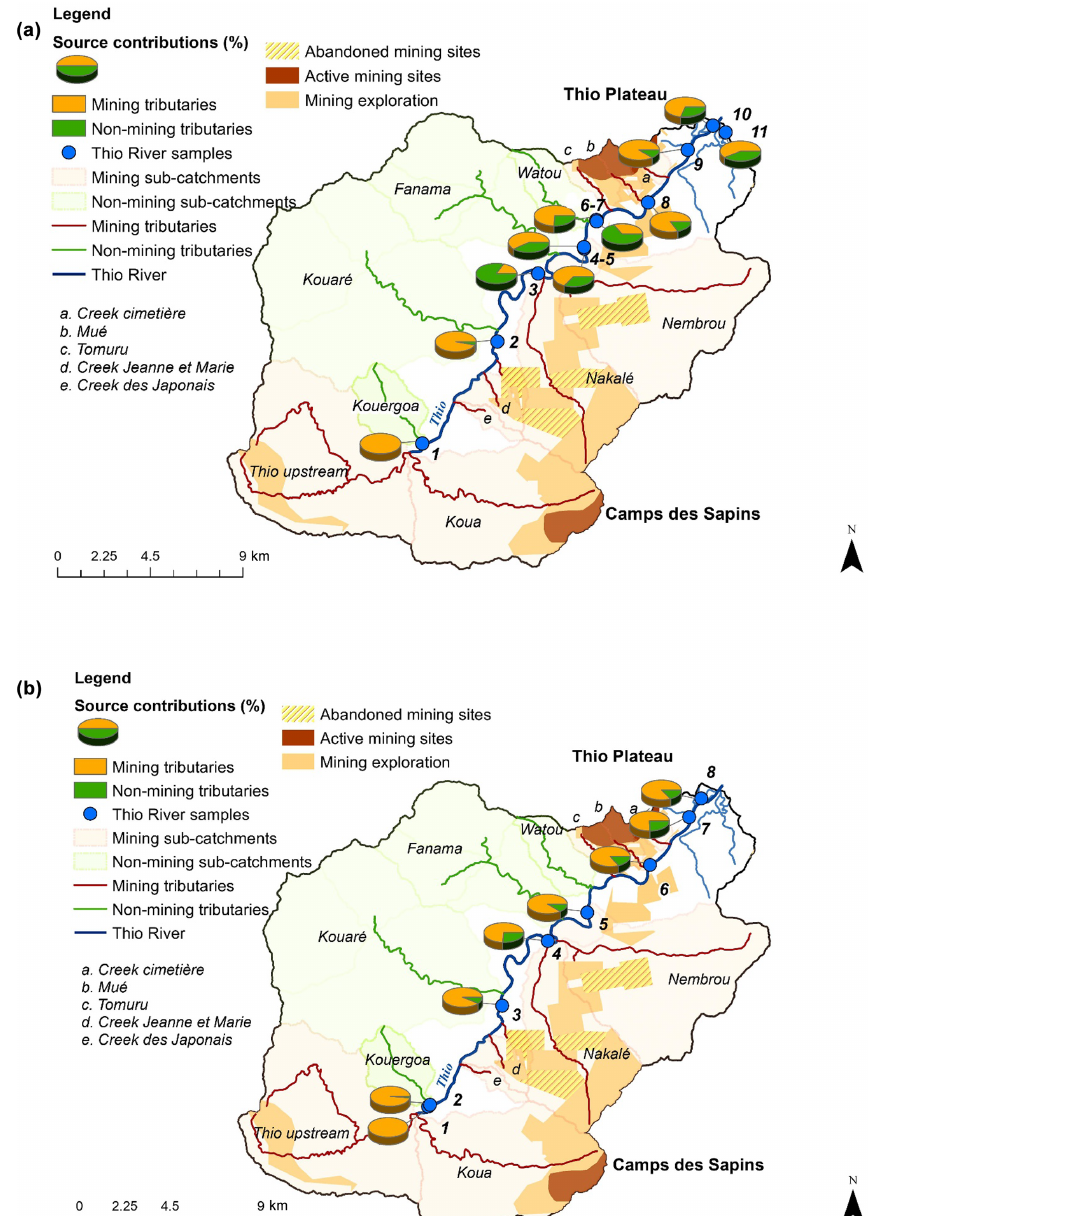
Figure 9. Relative contributions of mining and non-mining tributaries to the sediment collected in the Thio River during the 2015 (a) and 2017 (b) flood events using the colour + geochemistry